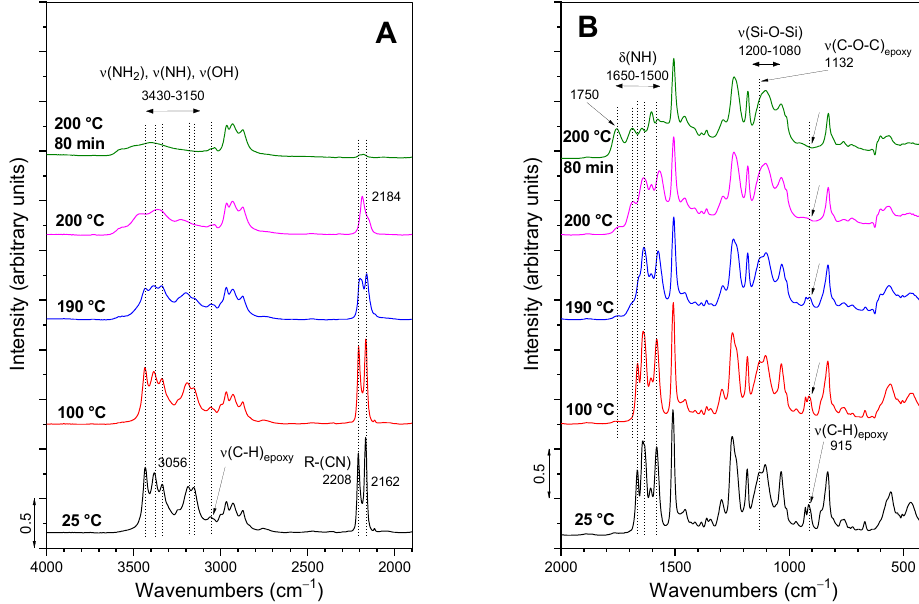
Figure 5. Time-dependent FT-IR absorbance spectra during the thermal curing process of formulation D-P in the spectral ranges: ( A ) 4000–1900 cm − 1 and ( B ) 2000–400 cm − 1 .